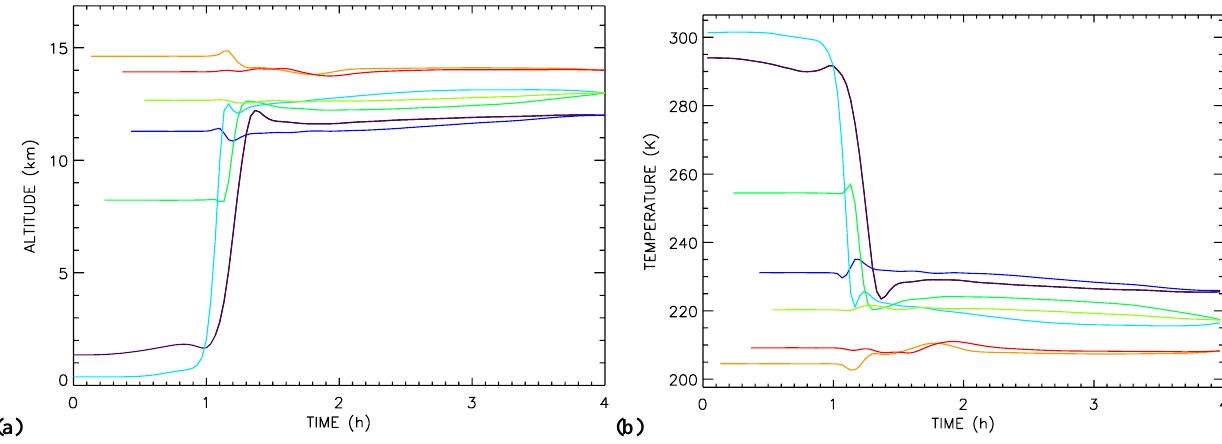
Fig. 3. Air parcel trajectories selected for the REF simulation. (a) altitude versus time and (b) temperature versus time.